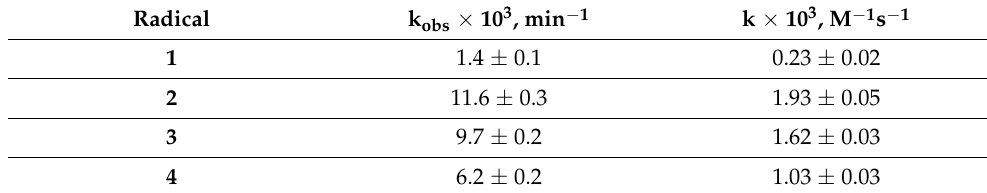
Table 3. Rate constants of reduction by ascorbate for radicals 1–4 (for details, see the experimental part).